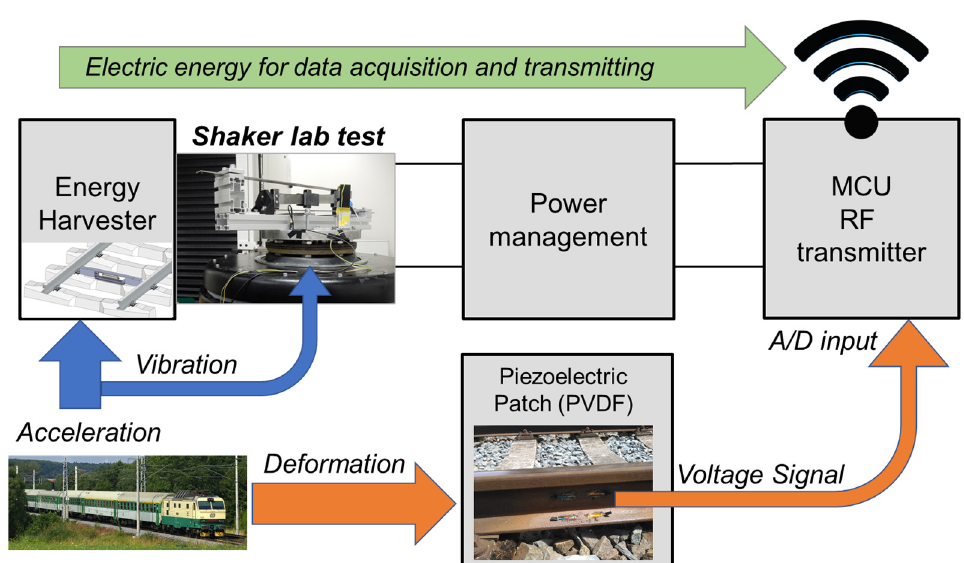
Figure 16. Proposed autonomous railway application of autonomous piezoelectric sensing. Video S3.